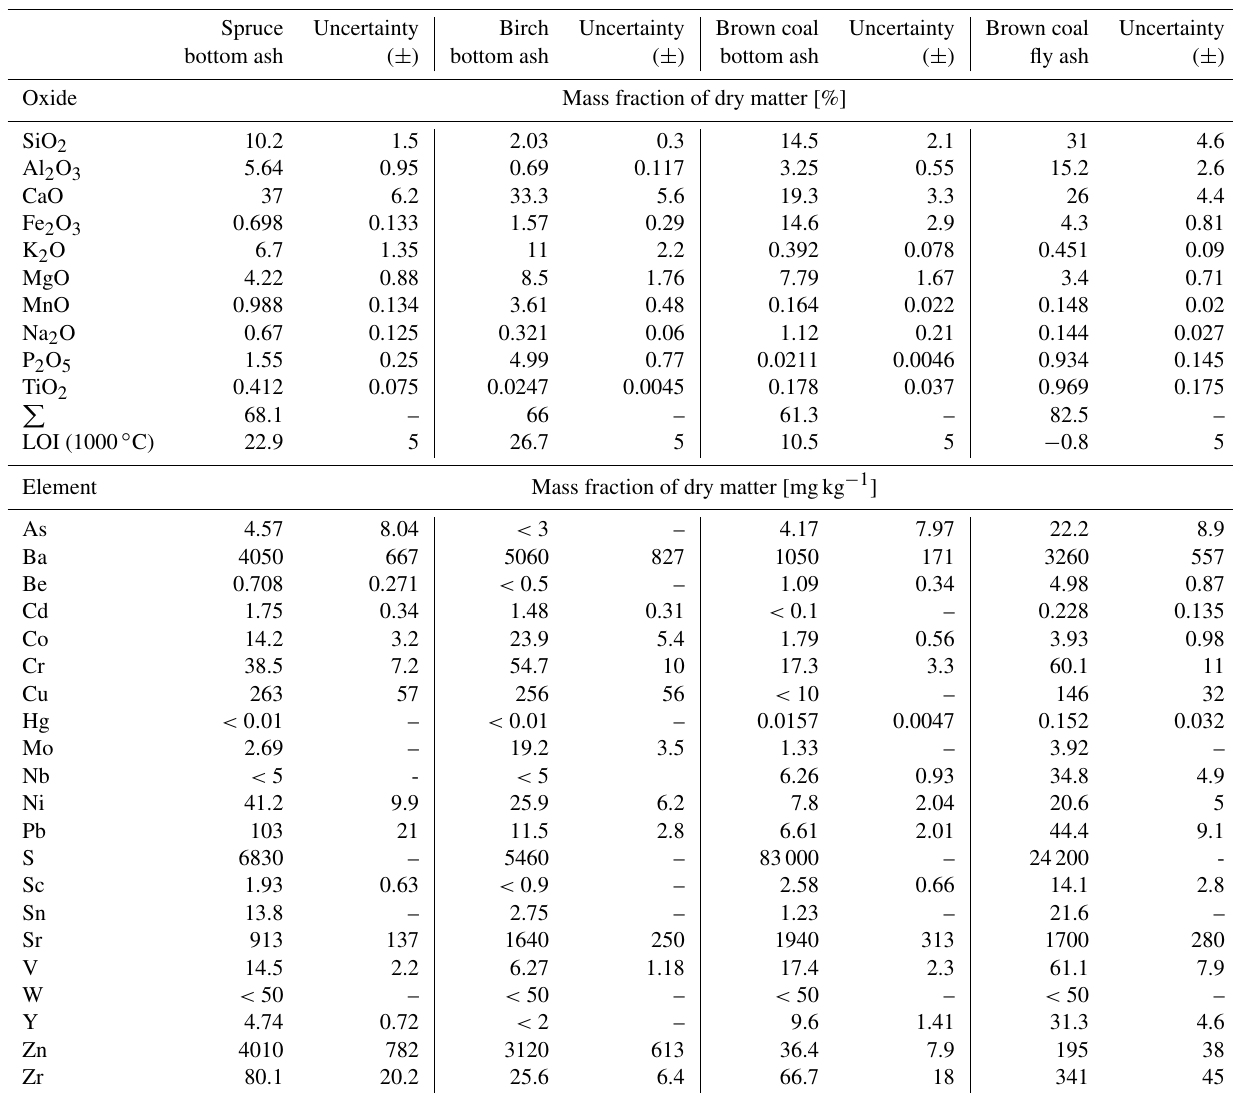
Table 3. Mass fractions in percent of certain oxides and elements in the dry matter of bottom ash from spruce, birch, and brown coal burning, as well as fly ash from brown coal burning. The numbers given here correspond to the bars depicted in Fig. 2. The loss on ignition (LOI) test was performed at 1000 ◦ C to assess the completeness of the combustion